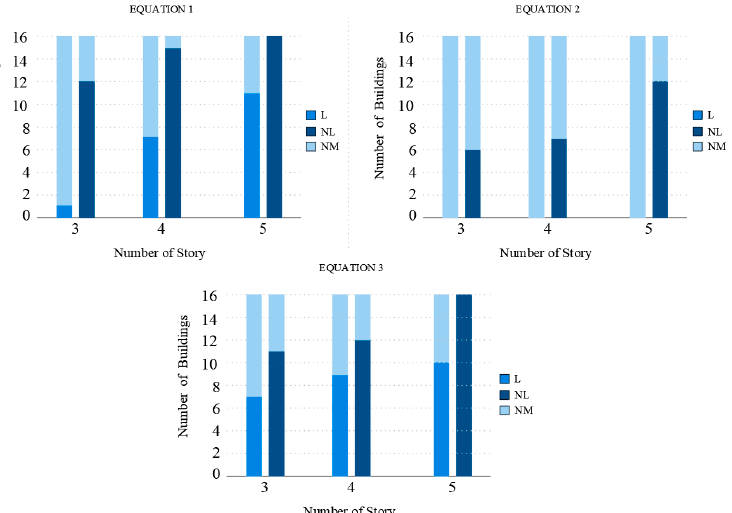
Figure 10. Distribution of buildings with sufficient performance according to the storey number / equation types.